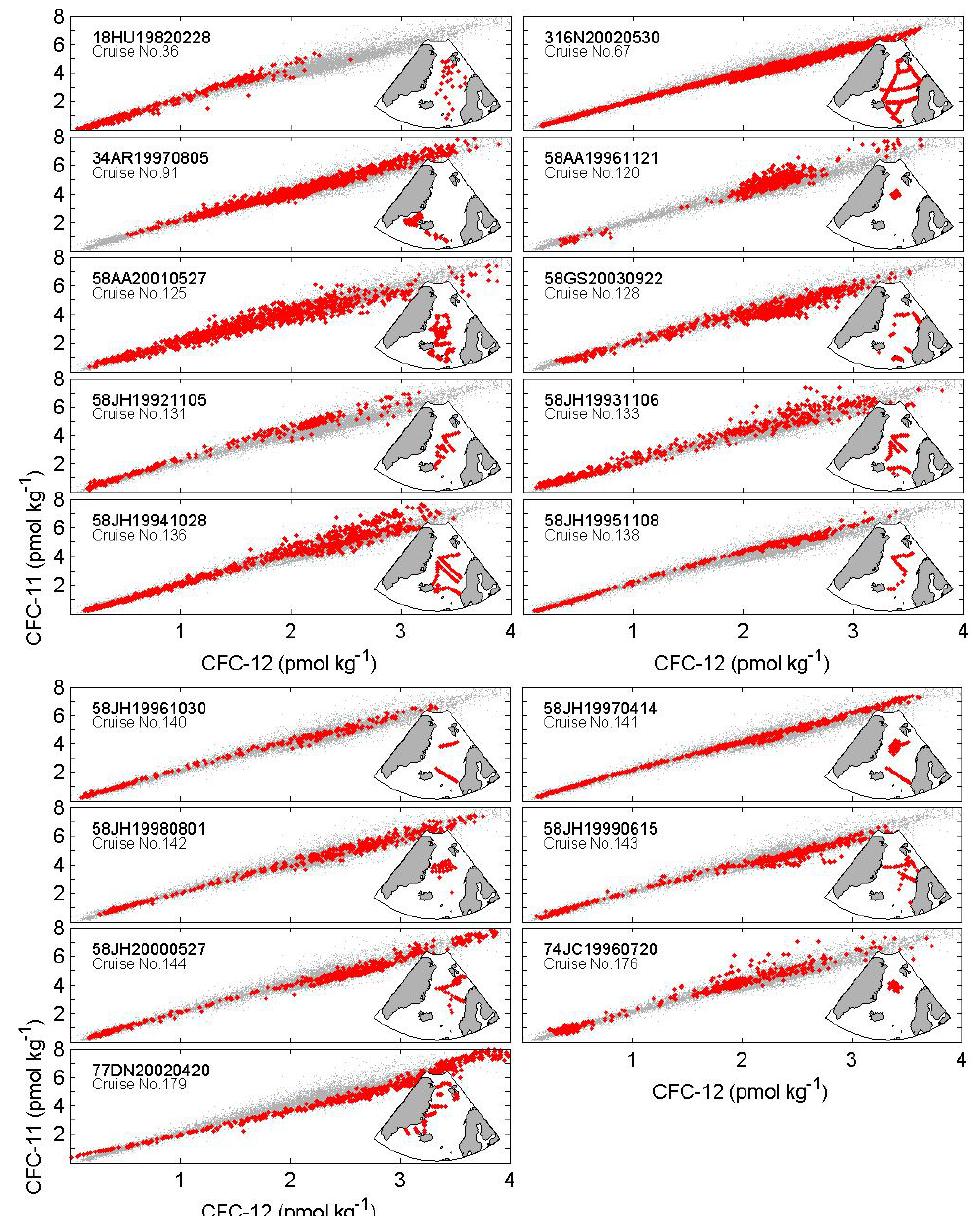
Figure 6. CFC-11 vs. CFC-12 for the Nordic Seas data. See Fig. 2 for